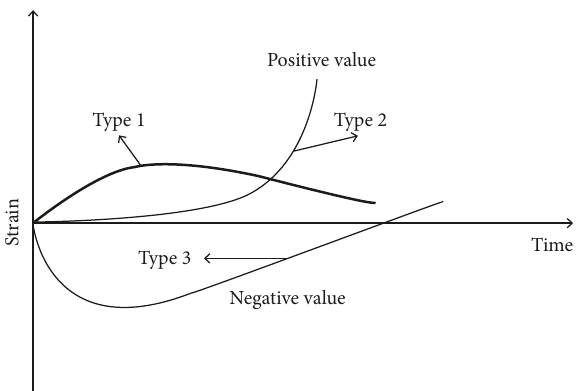
Figure 9: Schematic diagram of strain change